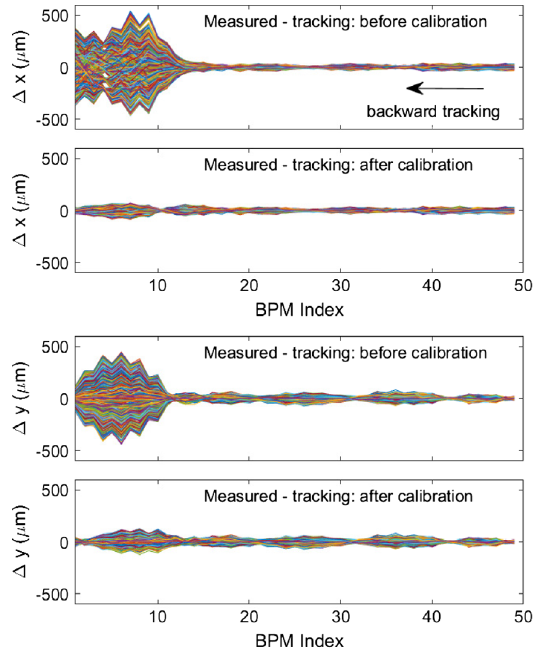
FIG. 12. Trajectory differences between measurements and tracking before and after fitting for the L3 Linac. Top: horizontal trajectories; Bottom: vertical trajectories.